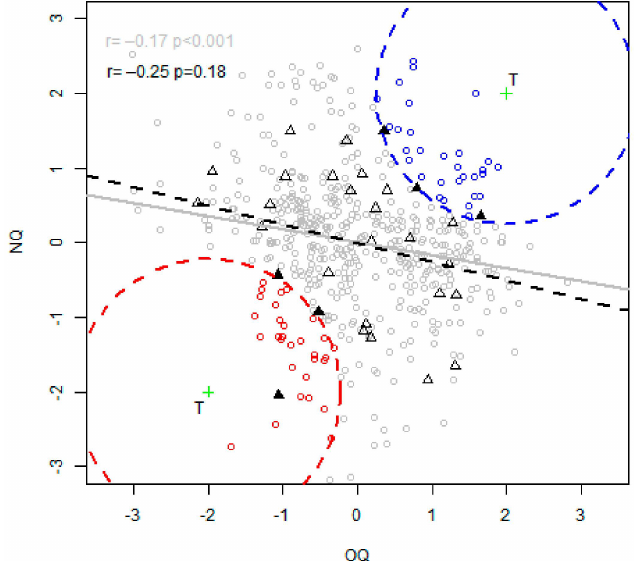
Figure 4. Nutritional and organoleptic indexes of the virtual (points) and real (triangles) animals. The correlation of the virtual (respectively real) animals is given in grey (respectively in black) in the top left corner. Regression (NQ~OQ) line for both virtual and real animals is added to visualize the correlation. Two targeted green crosses T were set to select the closest best (blue) and worst (red) virtual animals (and real animals filled in black for both